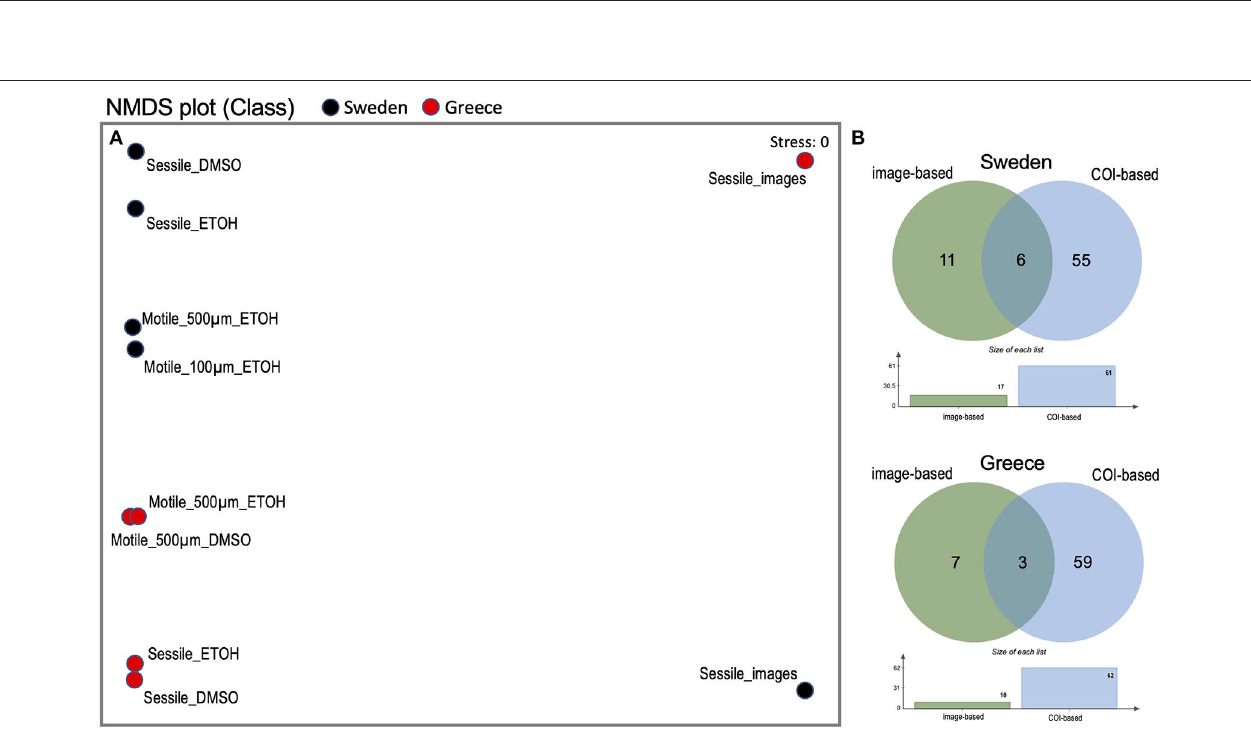
Frontiers in Marine Science |